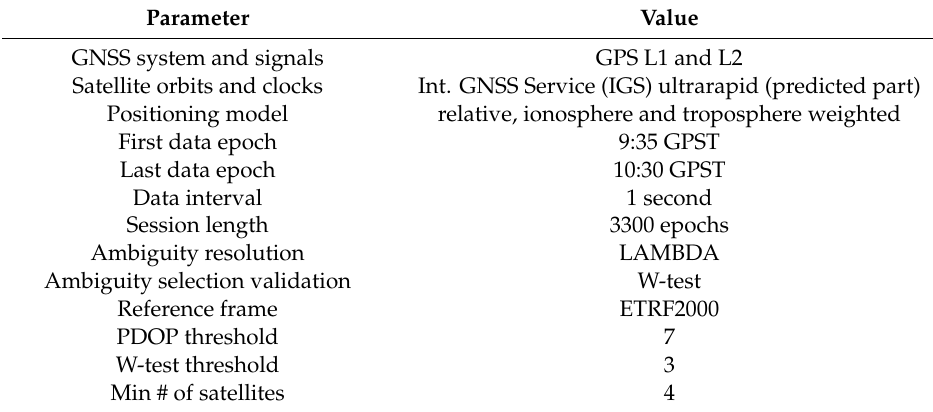
Table 4. Processing